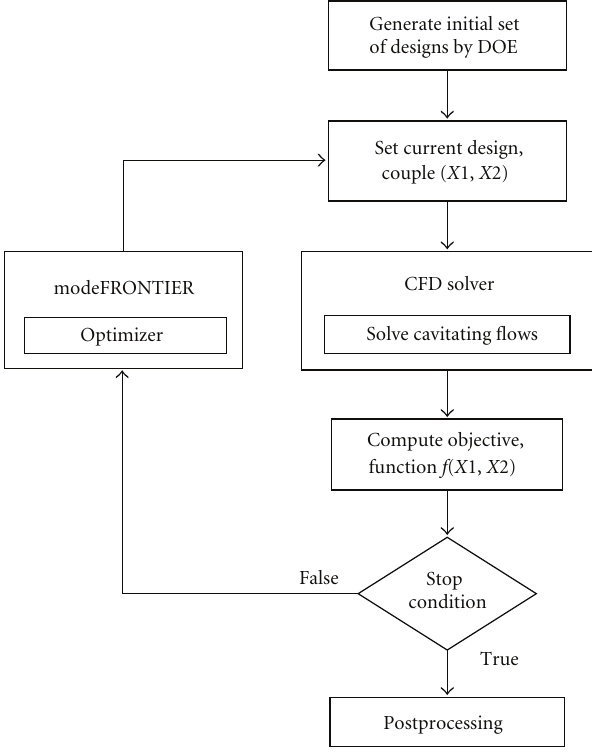
Figure 1: Logic of the optimization strategy.